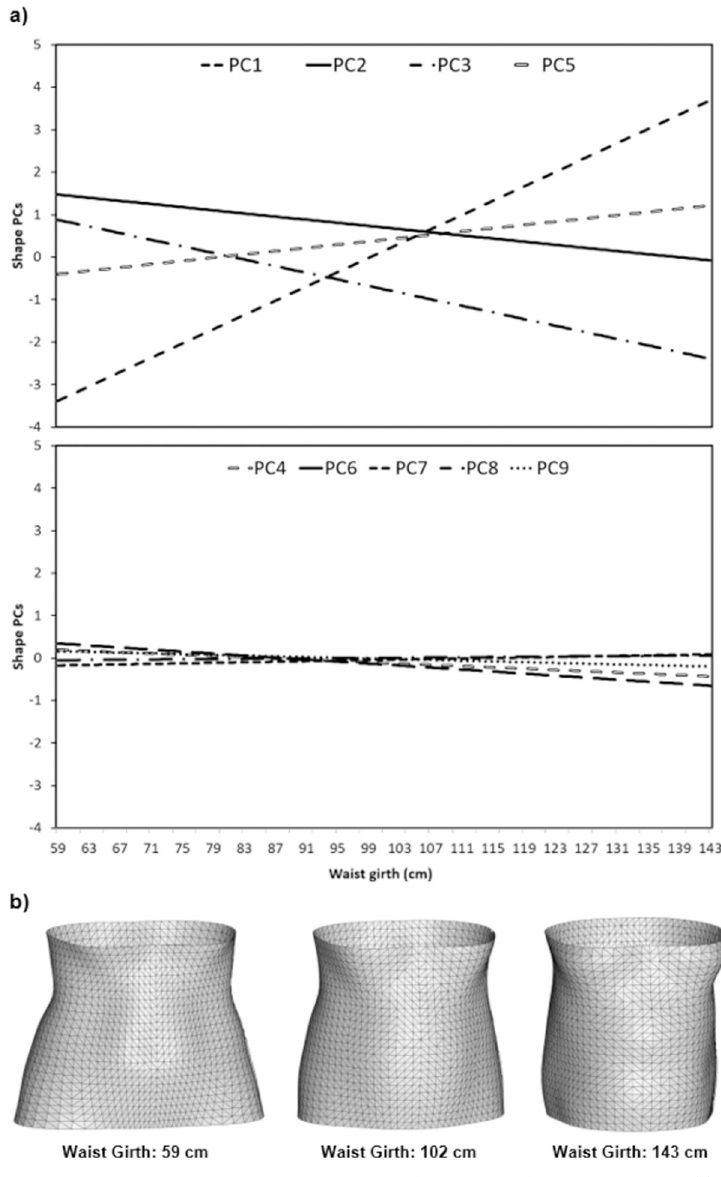
Fig 8. Relationship between body measures and shape PCs for female participants. (a) Predicted changes in shape PCs according to PLSR models. (b) Reconstructed torso shapes for females with waist girths of 59, 102 and 143 cm.